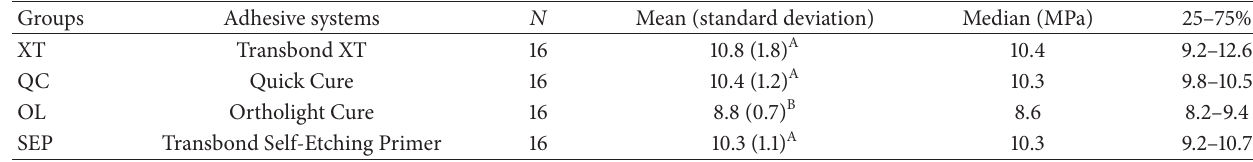
Table 3: Shear bond strength (MPa) analysis of orthodontic adhesives.